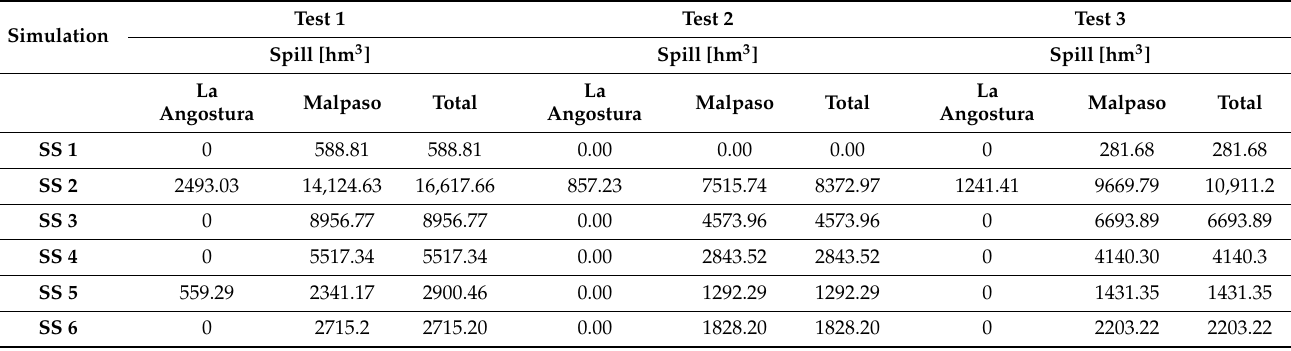
Table 6. Summary of the joint simulation of La Angostura and Malpaso dams: spill